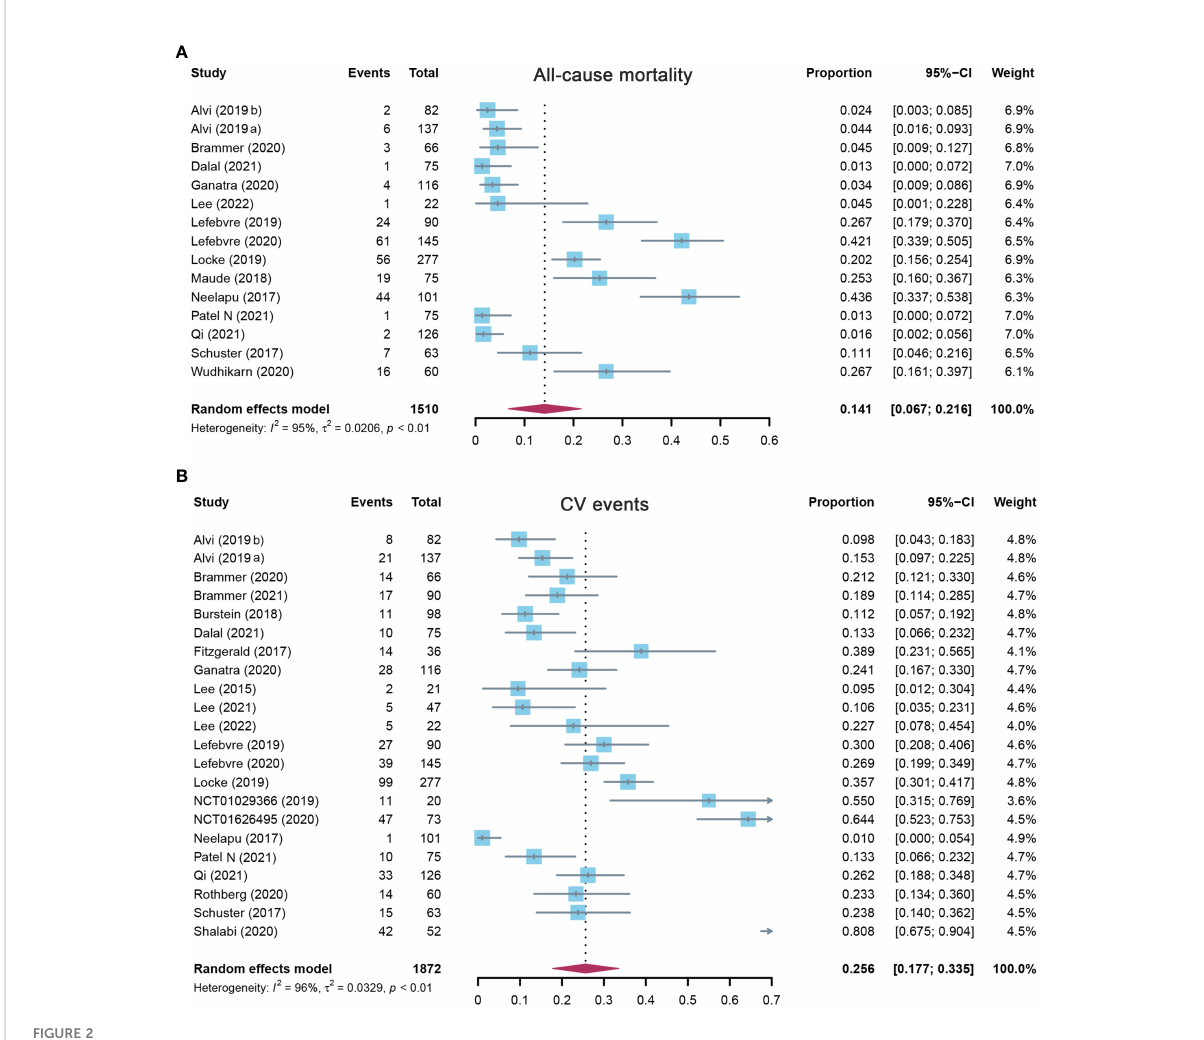
FIGURE 2 The forest plot of pooled incidence of (A) all-cause mortality and (B) CV event incidence rate in patients who received CAR-T cell therapy. CV, cardiovascular; CAR-T cell, chimeric antigen receptor T